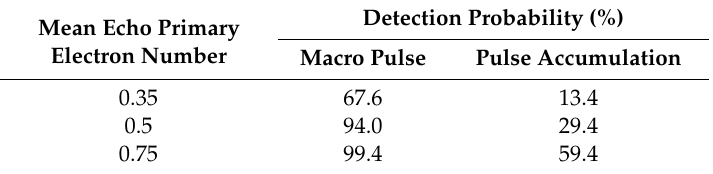
Table 3. Detection probability statistics.